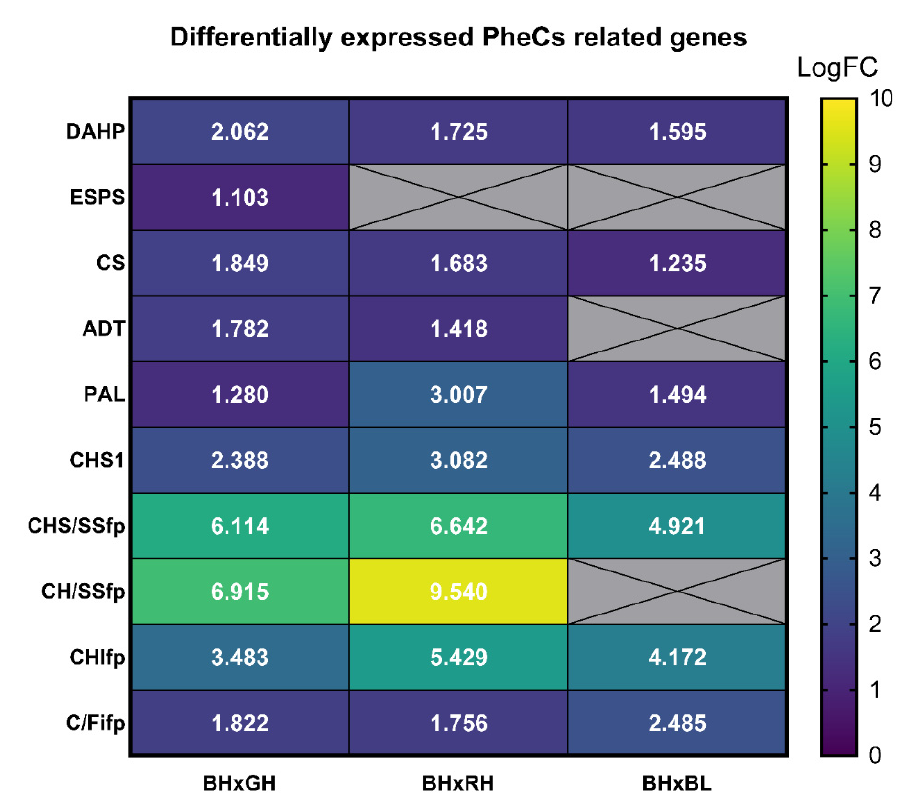
Figure 9. RNA sequencing analysis of PheC-related genes and genes of the shikimic pathway (which produces important substrates for PheC synthesis): Annotated genes are listed in rows from the top to the bottom in order of involvement in the biosynthetic pathways, whilst comparisons among light treatments are listed in columns (BH compared to GH, BH compared to RH, and BH compared to BL). Gray color denotes a missing value (in at least one of the datasets, the transcript was either not present or was excluded due to the parameters listed in Section 4.8). Displayed values correspond to logs of relative fold changes of gene expression (LogFC) between treatments and are also indicated by color according to the presented color scale. Specifications of light treatments: B (blue), R (red), G (green), L (low irradiance, 100 µmol m − 2 s − 1 ), and H (high irradiance, 400 µmol m − 2 s − 1 ).